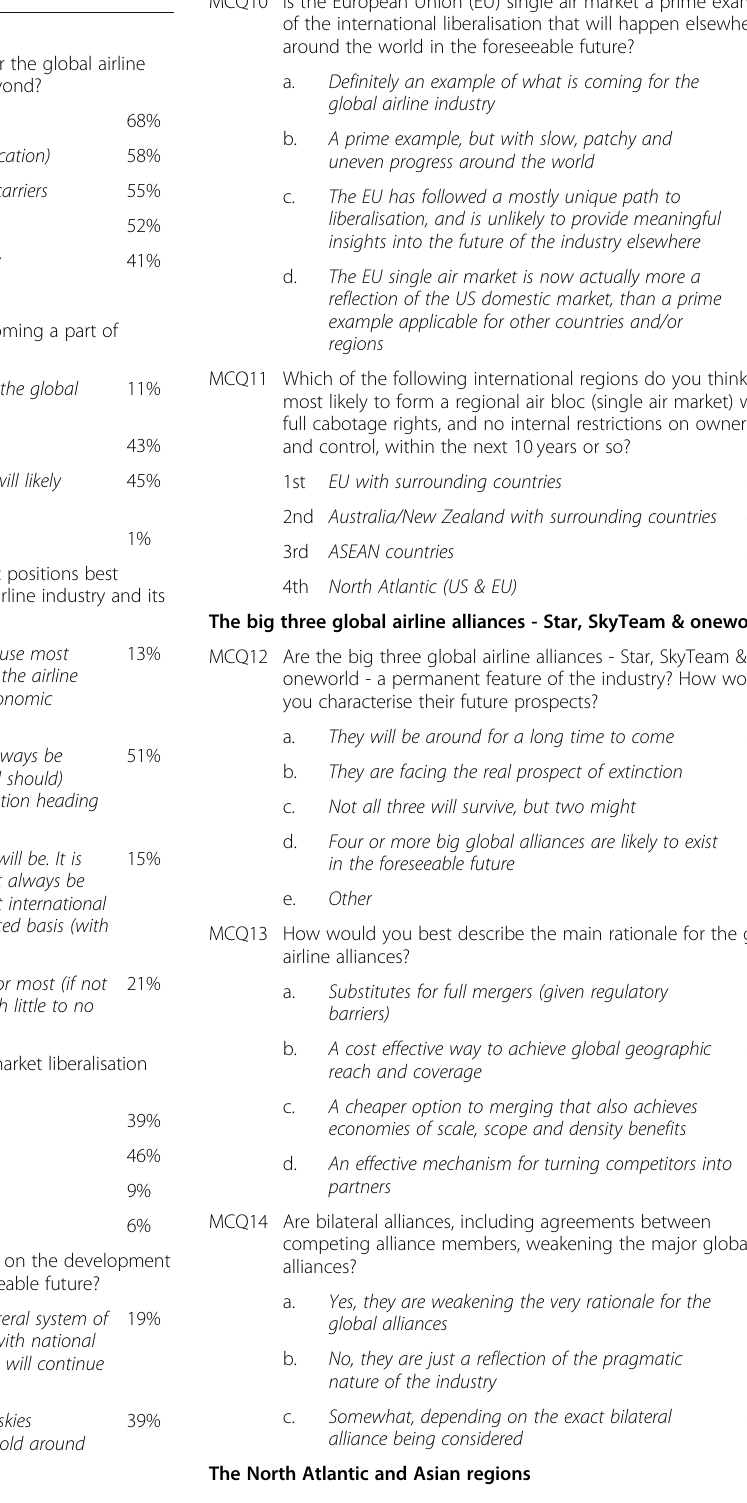
Table 1 Main survey 1: multiple choice questions (MCQs).